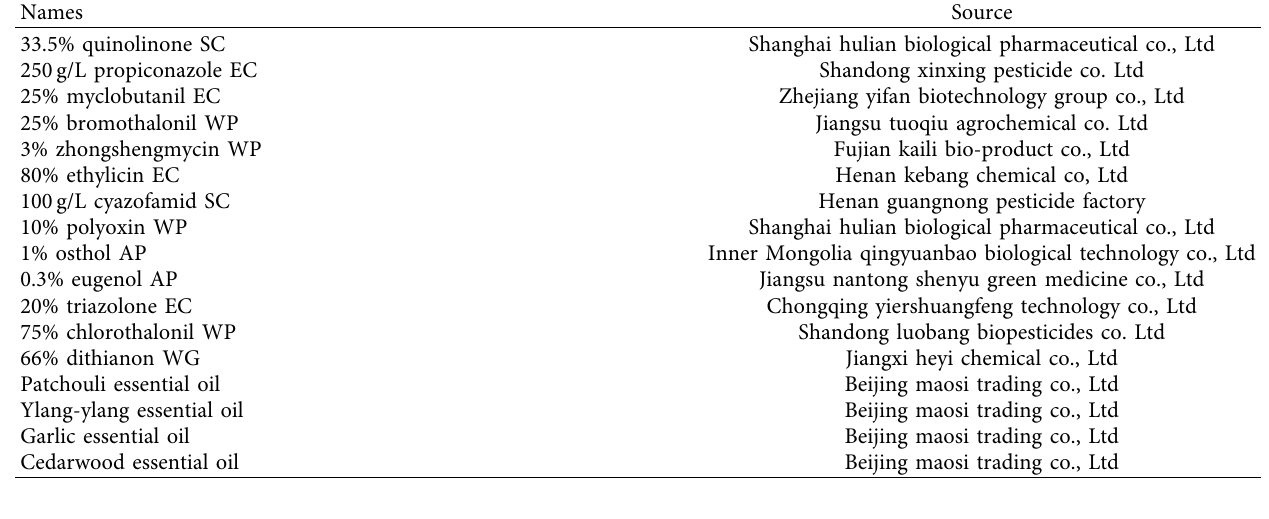
Table 1: List of 11 kinds of fungicides and 5 kinds of plant essential oils.